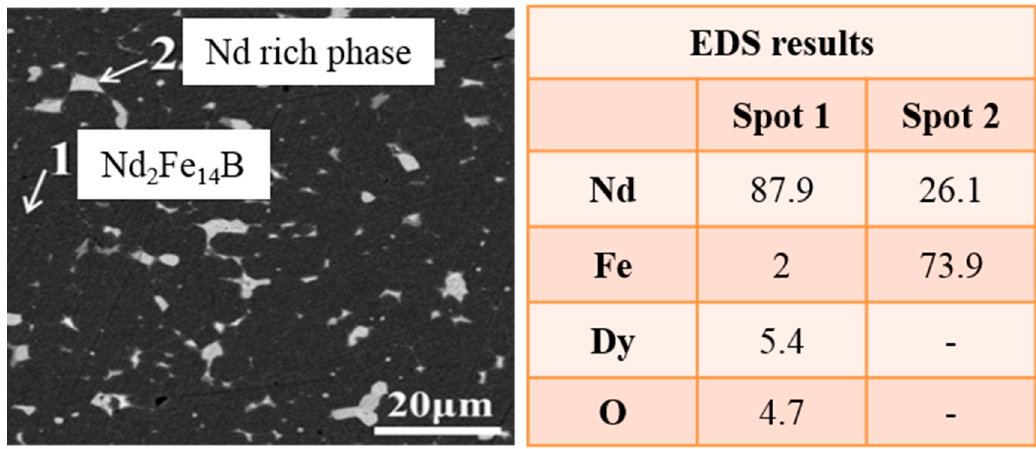
Figure 6. SEM-EDS analysis of NdFeB permanent magnets [54]; published by Elsevier, 2014.